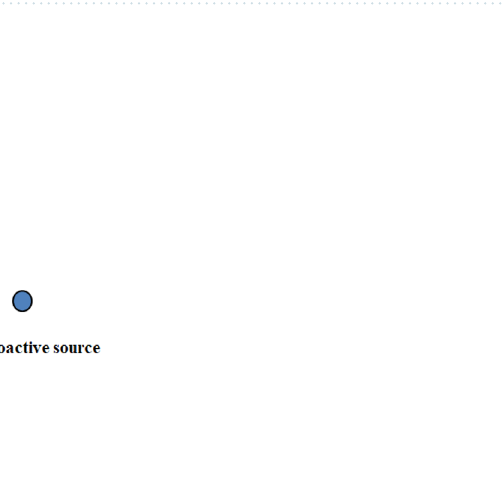
Figure 2. Structure of the characterized HPGe detector used for modeling in Monte Carlo